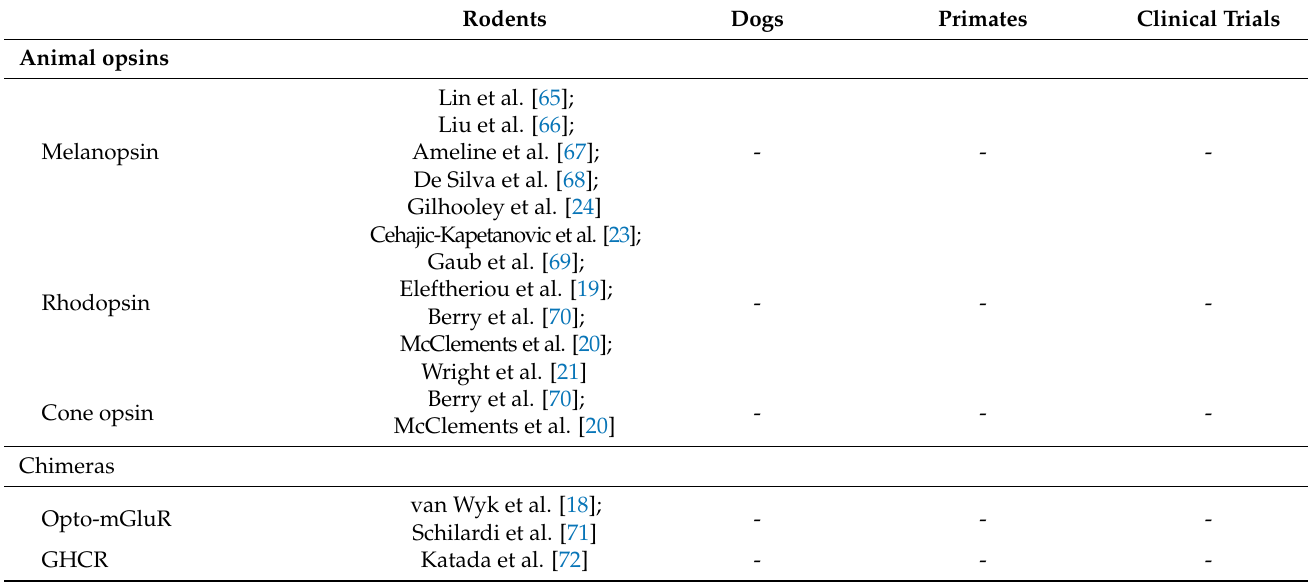
Table 1. Cont. Rodents Dogs Primates Clinical